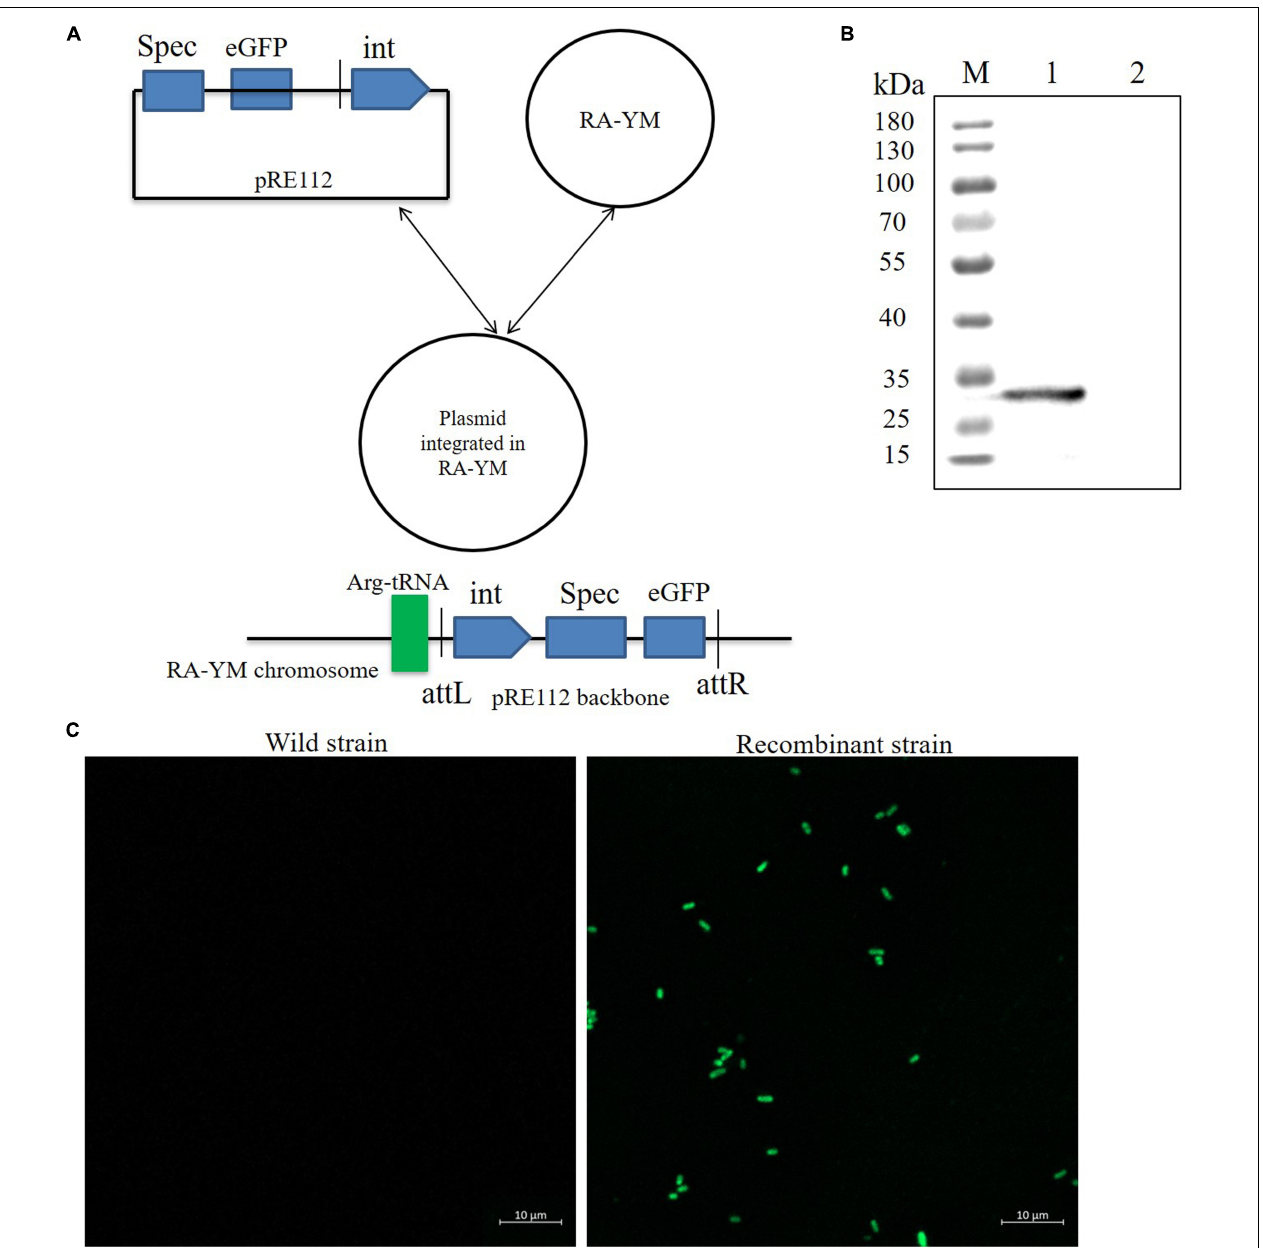
FIGURE 4 | Integrase mediated heterologous gene expression in R. anatipestifer RA-YM strain. (A) The eGFP integration vector construction diagram. (B) Western blot for detecting expression of eGFP protein. The eGFP fluorescent protein were observed by confocal microscope in R. anatipestifer RA-YM wild strain and recombinant strain of integrating eGFP expression (C)